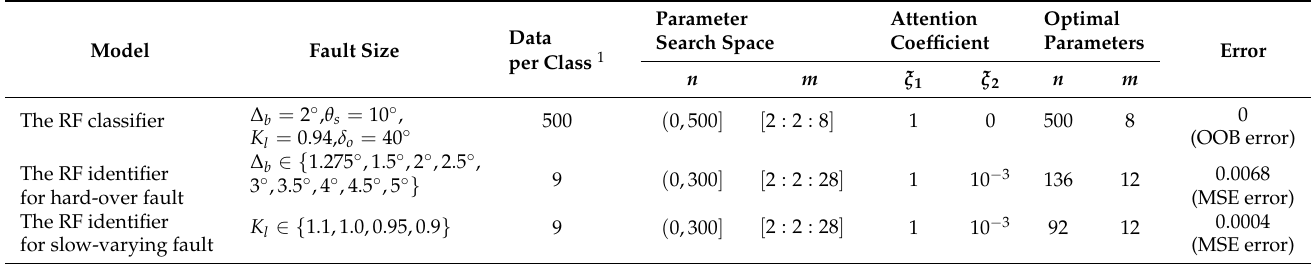
Table 2. Offline training settings and results of RF model.